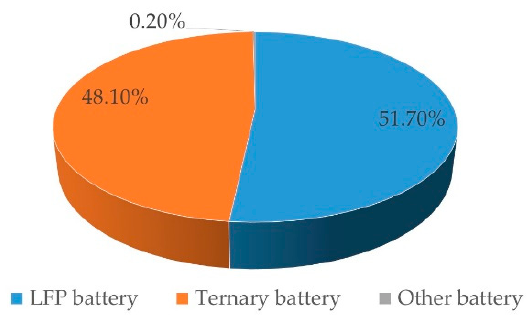
Figure 2. Proportion of power batteries loading in China in 2021.